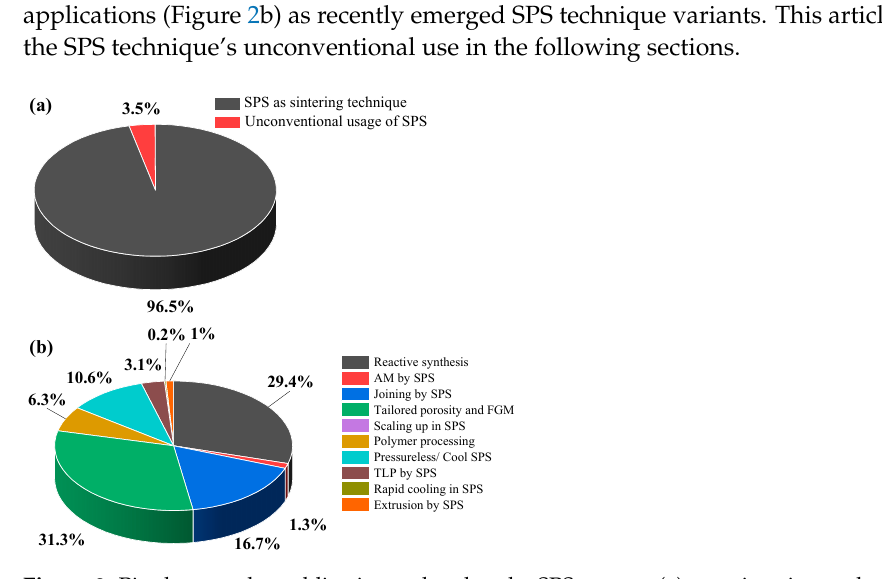
Figure 2. Pie chart on the publications related to the SPS process ( a ) as a sintering tool vs. unconventional usage, and ( b ) the relative distribution of unconventional processing by SPS (based on data collected from the Web of Science). Here, FGM stands for Functionally Graded Materials, and TLP stands for Transient Liquid Phase.